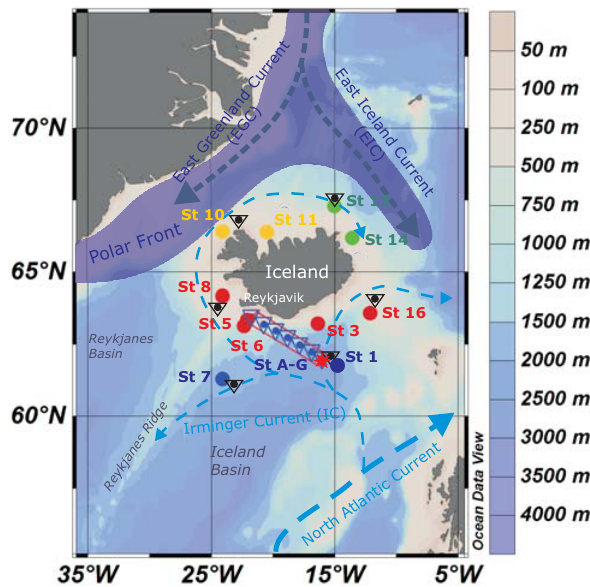
Figure 1. Bathymetric map of the study area with the location of the different sampling stations around Iceland. Filled circles indi- cate surface sediment stations with color coding according to the area of location, i.e., yellow and green for the northern stations, red for the shallow stations in the south of Iceland and blue for the deep southern stations. Black and blue inverse triangles with filled cir- cles indicate surface particulate matter stations around Iceland sam- pled during July 2011 and the transect from Iceland Basin (St A) to Reykjavik (St G) sampled during July 2012, respectively. The red star indicates the location of sediment trap deployment. Dashed blue arrows show the theoretical circulation of the different water